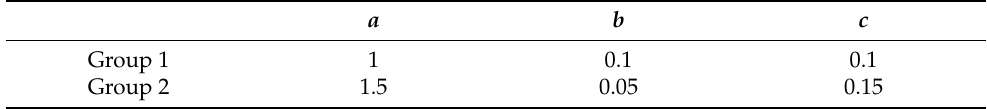
Table 1. The a , b , and c parameters for Equation (11).